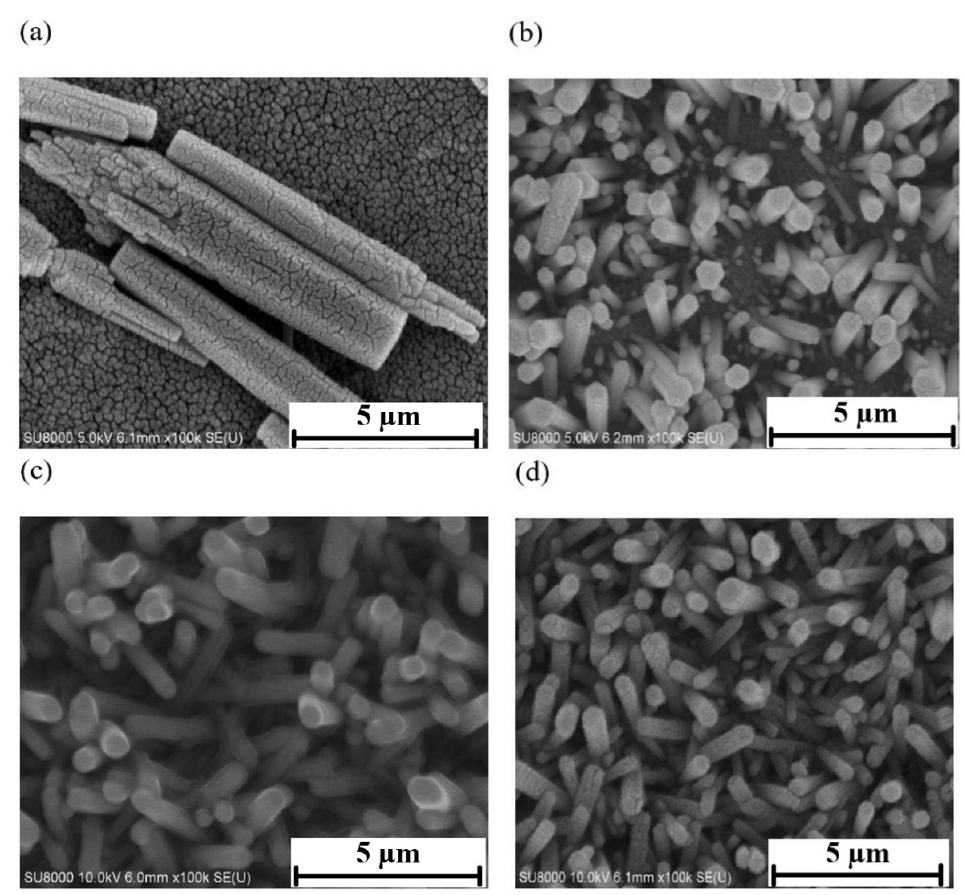
Figure 4. Hydrothermal growth of zinc oxide nanostructures. ( a ) 3 hours ( b ) 6 hours ( c ) 9 hours ( d ) 12